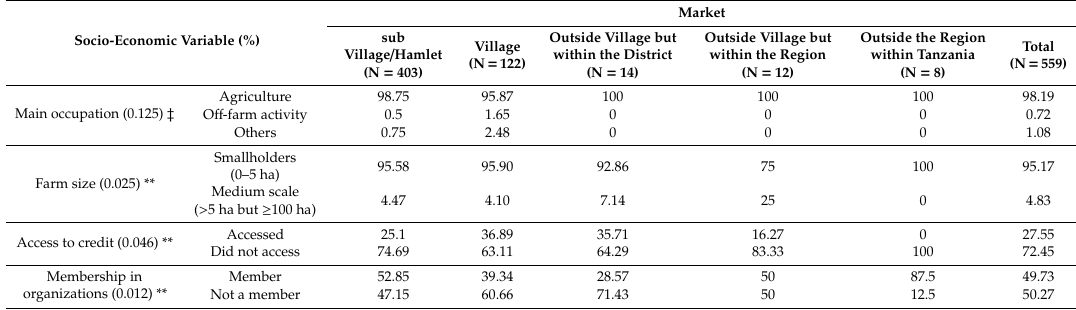
Table 4. The extent of farmers’ market integration.